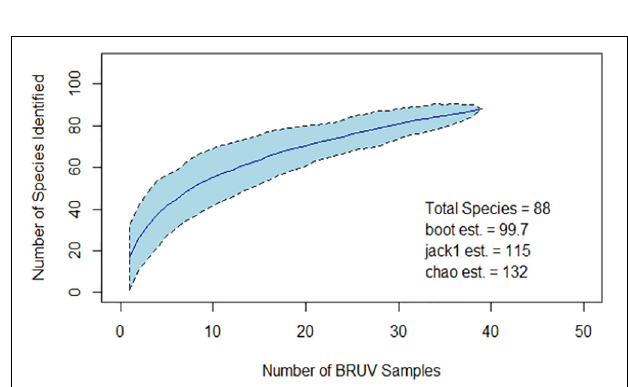
198 to 11, and mean abundance was 71 ( ± 43.84 sd.). Fork